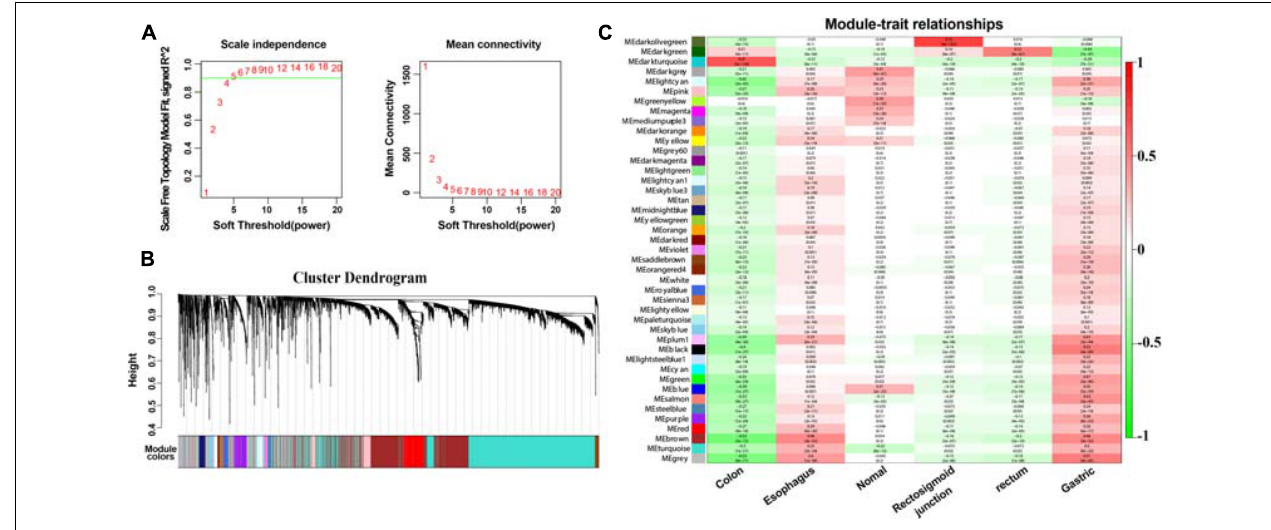
FIGURE 5 | WGCNA method and module identification of the cancers. (A) Scale independence and mean connectivity of soft-thresholding values ( β ). (B) Cluster dendrogram of filtered genes. (C) Correlation between the cancers and MEs.